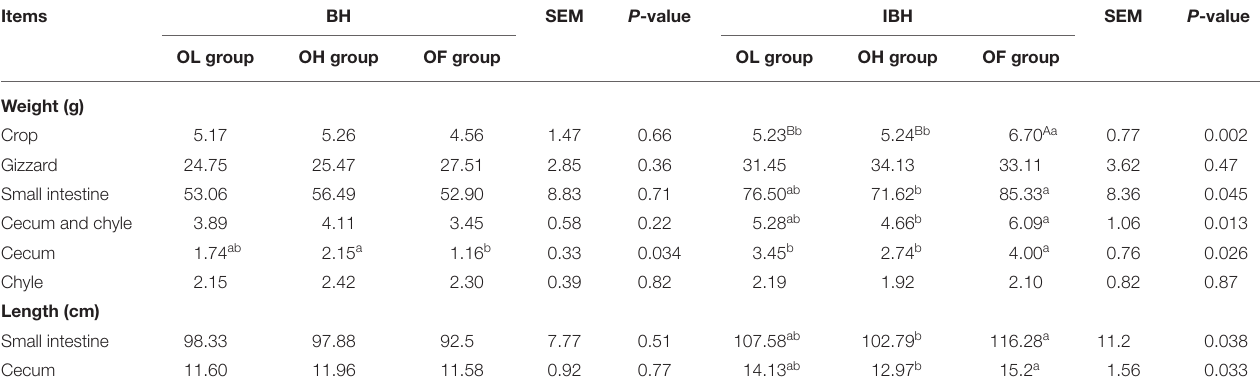
TABLE 3 | Effect of adding eubiotic lignocellulose on the development of gastrointestinal tract among groups in BH and IBH. Items BH SEM P -value IBH SEM P -value OL group OH group OF group OL group OH group OF group Weight (g)